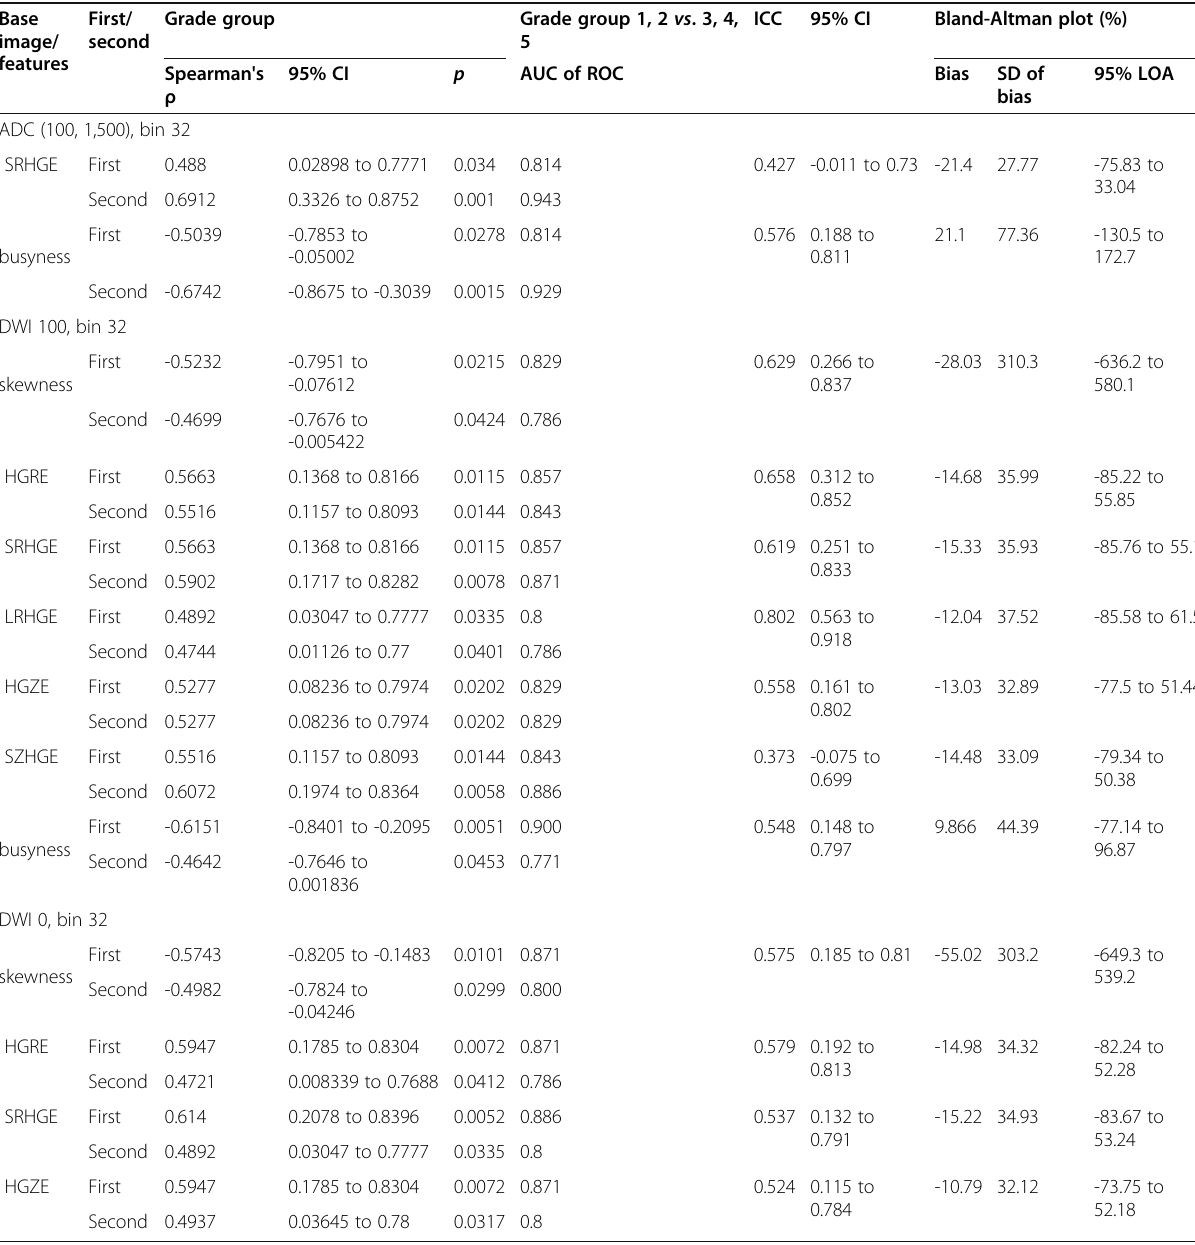
Table 4 Summary of the correlation between features and grade group as well as the repeatability in transition zone cancer Base